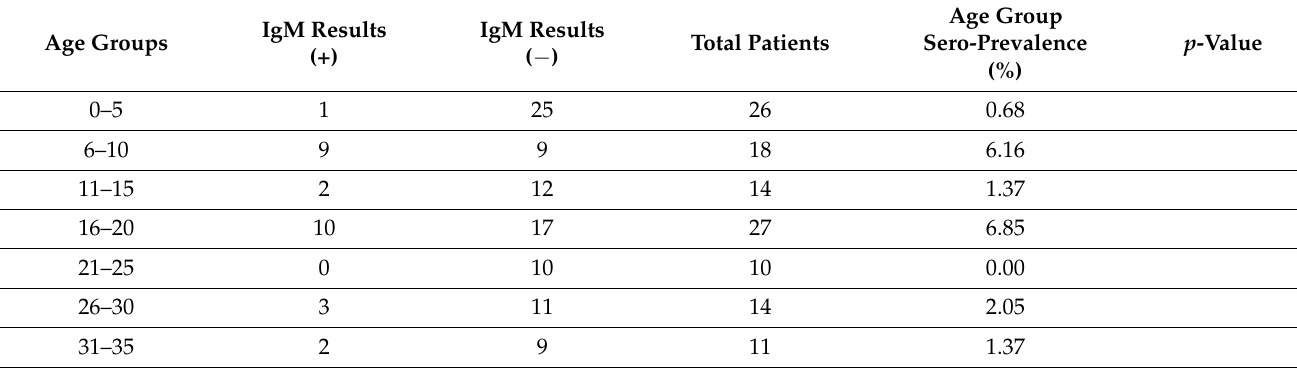
Table 3. Dengue virus infection detection among patients in Mubi by age